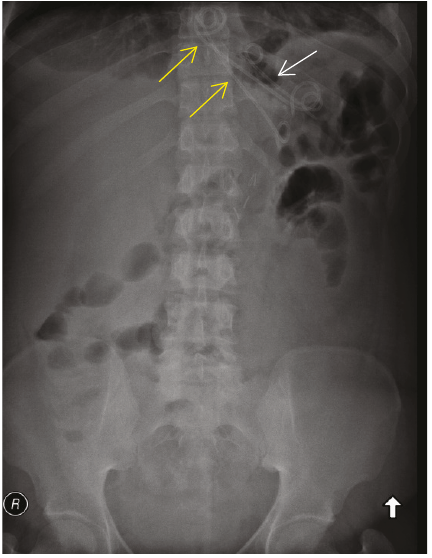
Figure 3: X-ray abdomen showing the displacement of one double- pigtail drain into the collection (white arrow). A satisfying double- pigtail drain position across the leak ori fi ce (yellow